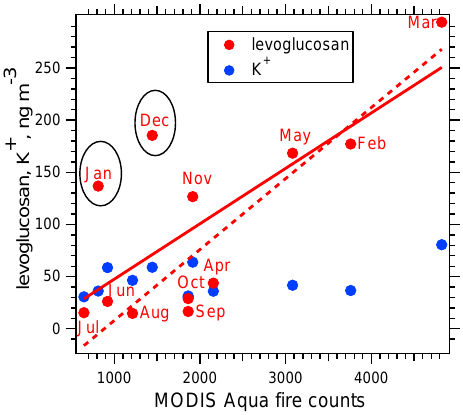
Fig. 8. Correlations of monthly mean concentrations of levoglu- cosan and K + versus fire counts. The red solid line is the fit of levoglucosan-fire counts correlation ( r 2 = 0 . 54). The red dashed line is the fit without January and December ( r 2 = 0 .